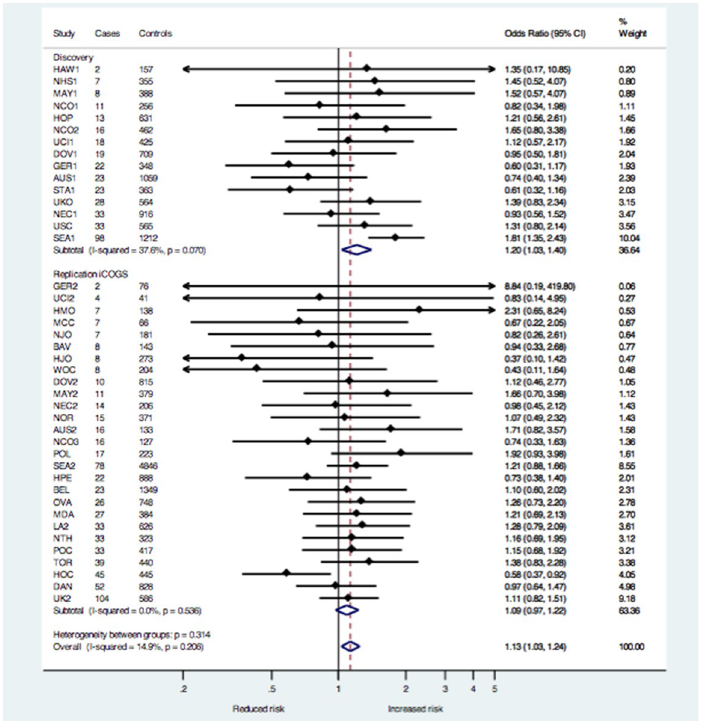
Figure 1. Forest plot of the study-specific (filled diamonds) and pooled (open diamonds) odds ratios and 95% confidence intervals (solid horizontal lines) for the association between rs495139 and risk of MOC under the ordinal genetic risk model in the discovery and iCOGs samples. The total sample size in the meta-analysis is 1019 MOC cases and 23,666 controls of European ancestry. Dashed vertical line represents overall summary estimate–odds ratio. Individual study estimates are adjusted for ancestry and pooled estimates are adjusted for ancestry and study. See Table 1 footnote for details regarding sample size.